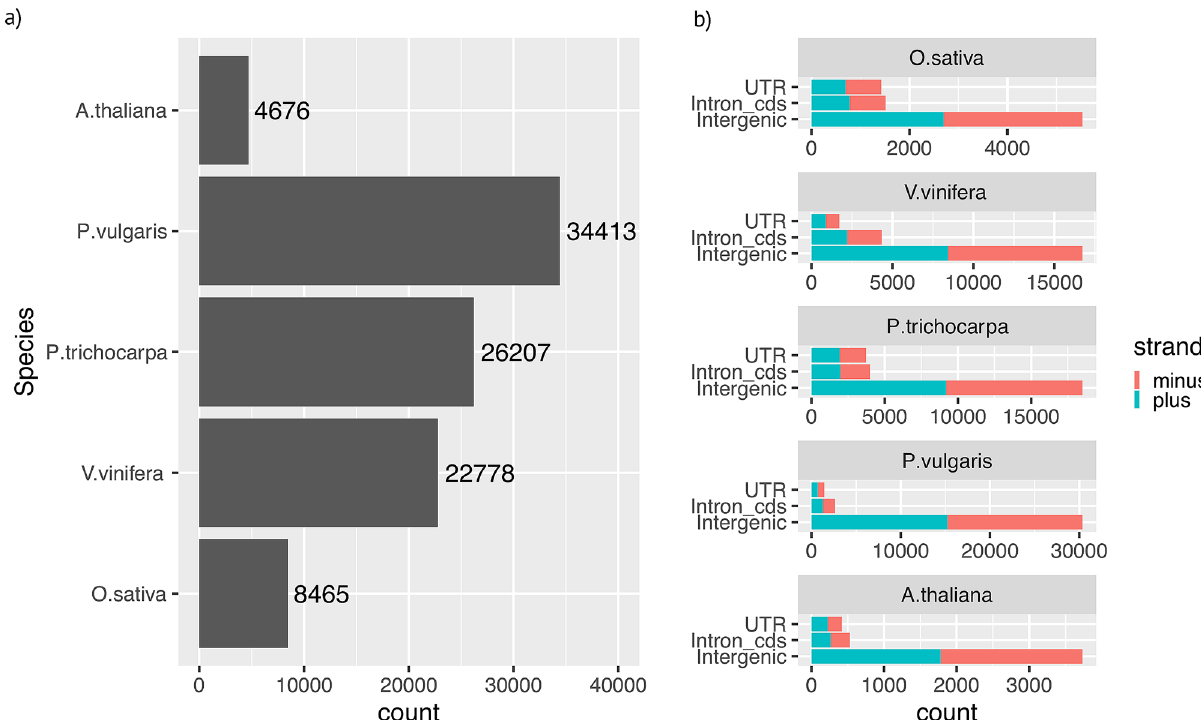
Figure 2. Numbers and distributions of pseudogenes in the five investigated species. ( a ) Total numbers of pseudogenes identified in each species. ( b ) Pseudogene distributions based on their positions in either DNA strands. UTR untrnslated 5’, 3’ exons of genes and introns therein, Intron _ cds intron of the coding sequences, Intergenic pseudogenes that map between two consecutive